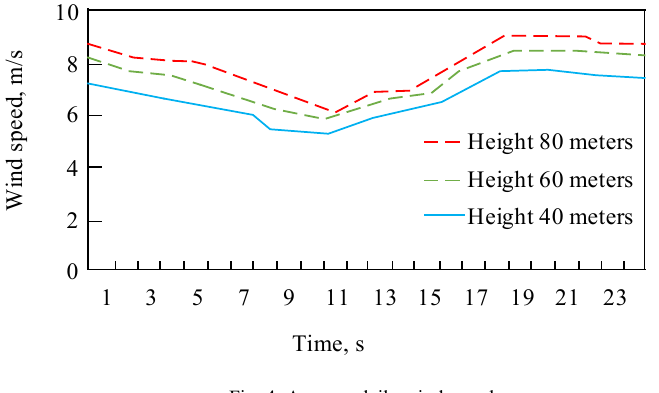
Fig. 4. Average daily wind speed.